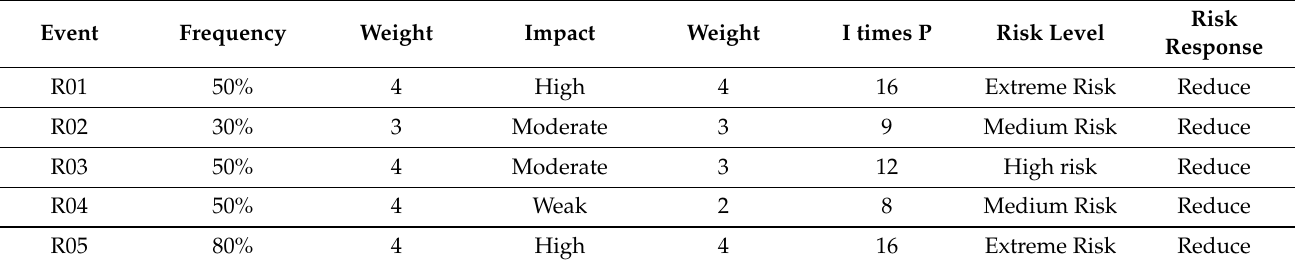
Table 7. Risk Assessment of the Manage Corporate Data